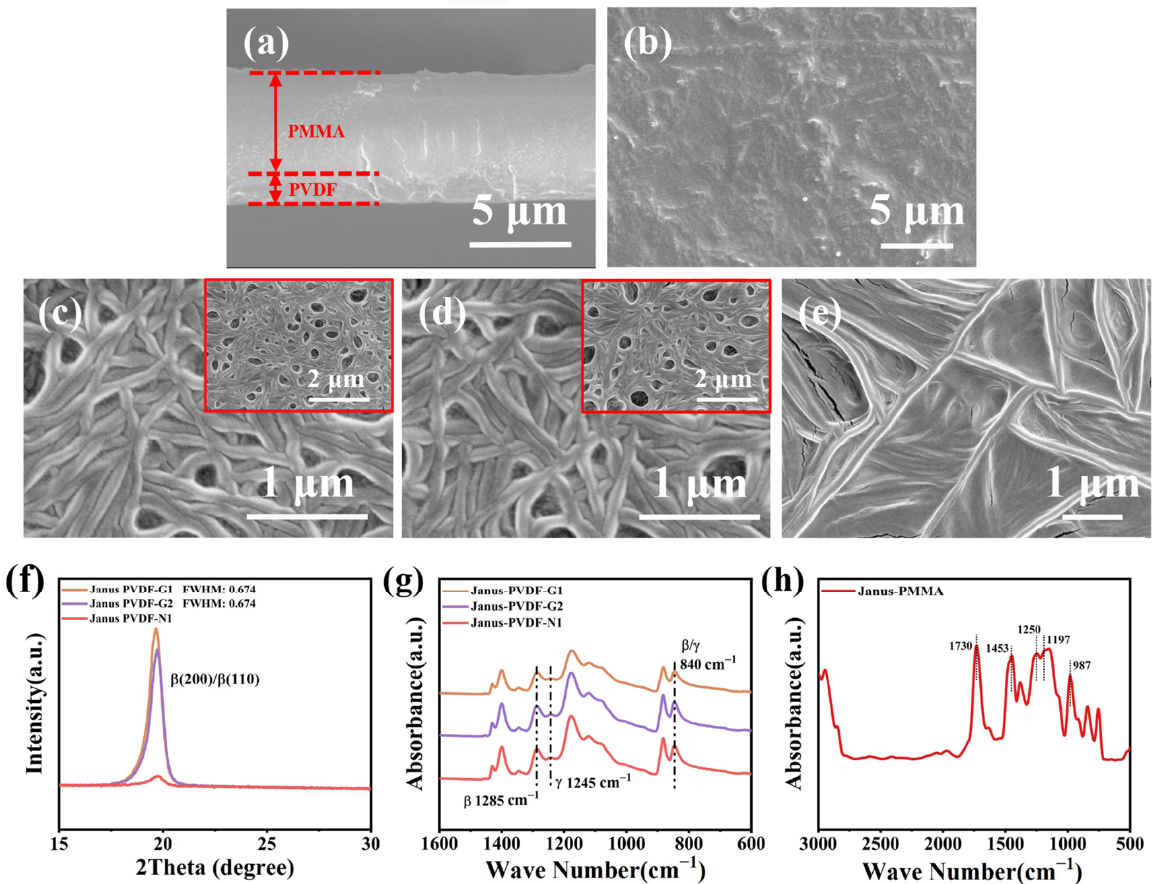
Figure 1. Cross-section image of Janus membrane ( a ), scanning electron microscope (SEM) images of PMMA film ( b ), P(VDF-TrFE) coating recrystallized on Gr/n-Si substrate with light illumination ( c ), P(VDF-TrFE) coating recrystallized on Gr/n-Si substrate without light illumination ( d ), P(VDF-TrFE) coating recrystallized on n-Si substrate ( e ). XRD patterns ( f ) and FTIR spectra ( g , h ) of P(VDF-TrFE) coatings and PMMA film.